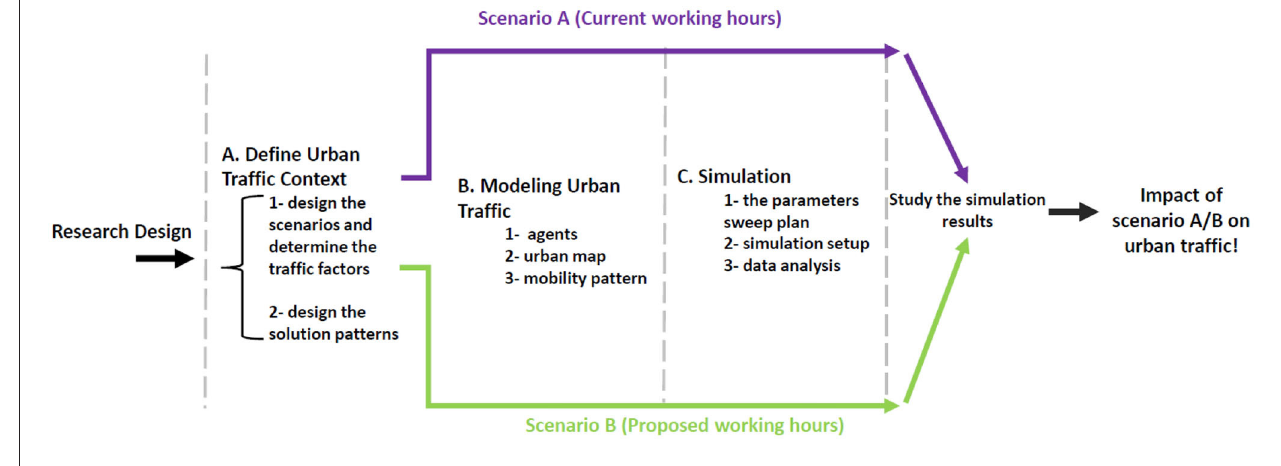
FIGURE 1 | Flow chart of research design in three phases (source: the authors).